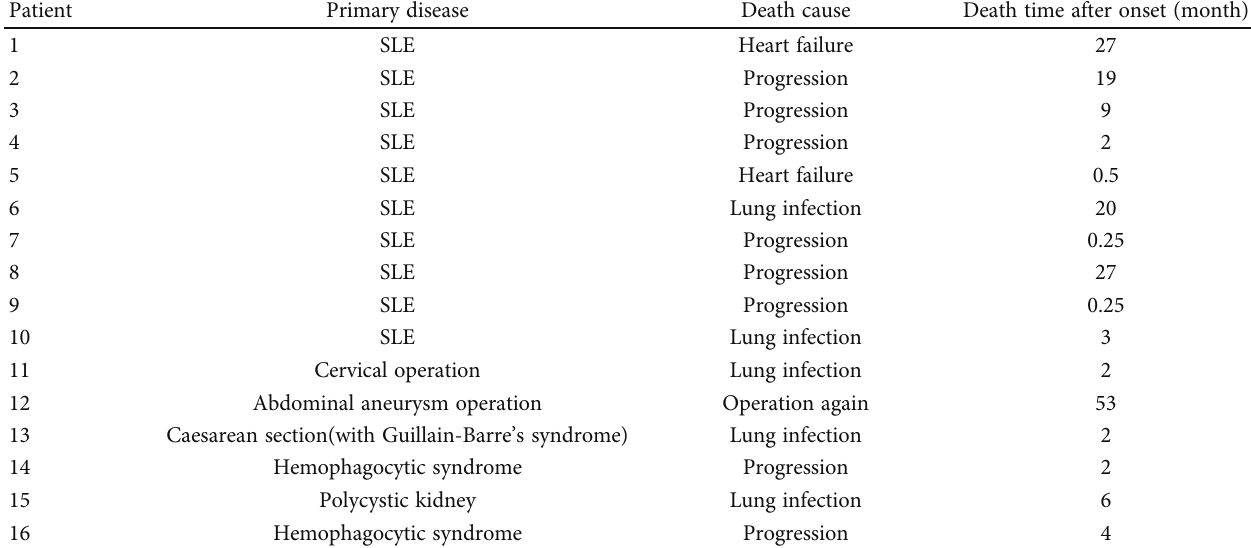
Table 6: The cause and the time of death.